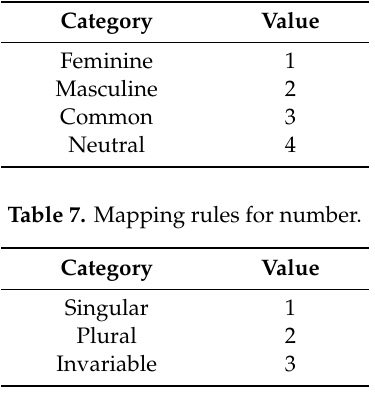
Table 6. Mapping rules for gender.